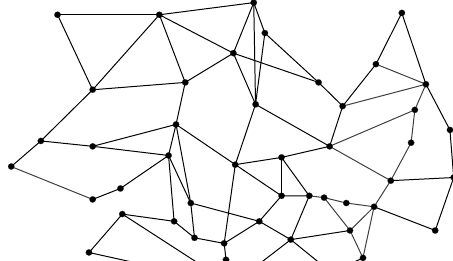
Figure 4. Topology of Abilene.